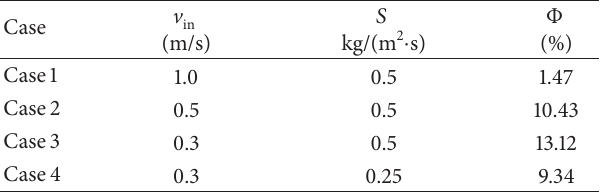
Table 1: Values of Φ in different simulation